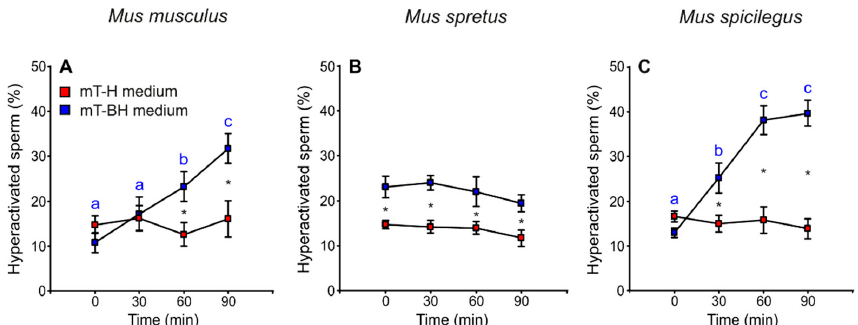
Figure 7. Variation in the proportion of hyperactivated sperm during incubation of sperm cells from three mouse species ( M. musculus , M. spretus , M. spicilegus ) under non-capacitating conditions (mT-H medium) and capacitating conditions (mT-BH medium). Data are means ± SE ( n = 7 in M. musculus , n = 8 in M. spretus , and n = 6 in M. spicilegus ). Red squares: non-capacitating conditions, mT-H medium under air. Blue squares: capacitating conditions, mT-BH medium under 5% CO 2 /air. ( A – C ) Percentage of hyperactivated sperm (%). ( A ) M. musculus . ( B ) M. spretus . ( C ) M. spicilegus